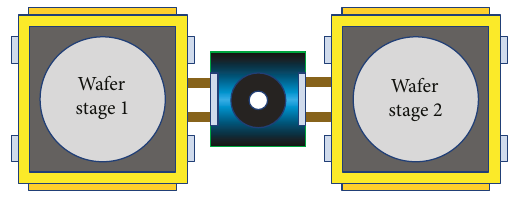
Figure 1: The sketch diagram of dual